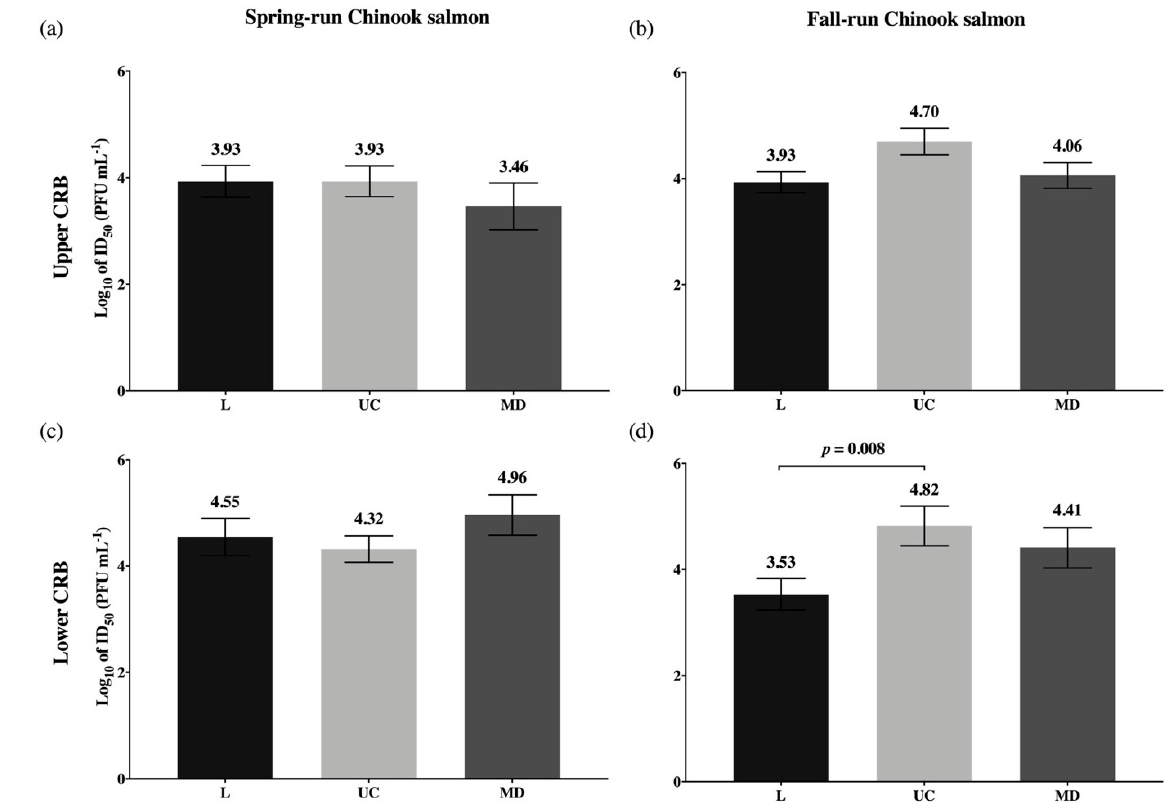
Figure 5. Estimates of viral dosage needed to infect 50 percent (ID 50 ) of juvenile Chinook salmon with L, UC, and MD strains of IHNV by batch immersion. ID 50 estimates (log 10 PFU mL − 1 , ± SE) are reported for spring-( a , c ) and fall-run ( b , d ) Chinook salmon of the upper ( a , b ) and lower ( c , d ) Columbia River Basin at 3 days post exposure. Significant differences between the ID 50 values generated are indicated as Welch-Satterthwaite 2-tailed t -test p values. To account for multiple pairwise comparisons, the 0.05 significance level was Bonferroni-corrected to α = 0.0166.